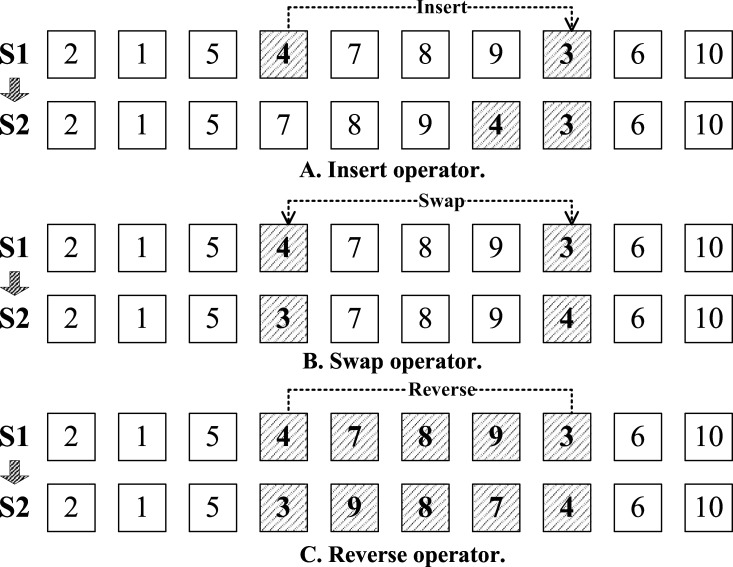
Mutation operators.